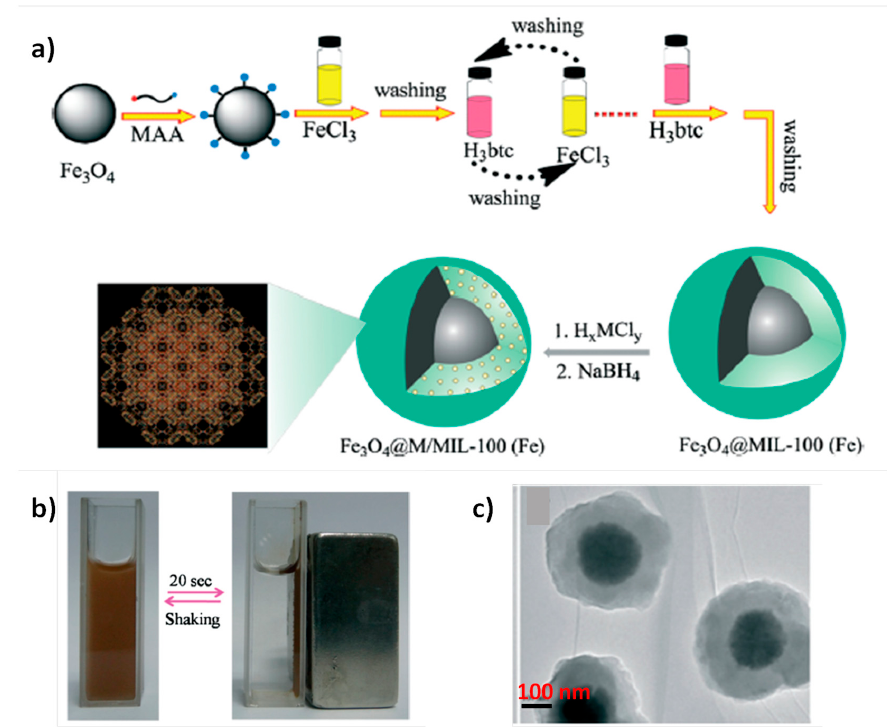
Figure 7. ( a ) Route followed for the fabrication of Fe 3 O 4 @M/MIL-100 (Fe) (M = Au, Pt, Pd) microspheres. MAA, mercaptoacetic acid; H 3 btc, 1,3,5-benzenetricarboxylic acid. ( b ) Magnetic separation–redispersion process of Fe 3 O 4 @Pt/MIL-100(Fe) microspheres. ( c ) TEM images of individual Fe 3 O 4 @MIL-100 (Fe) core–shell nanospheres after 60 assembly cycles. Reproduced